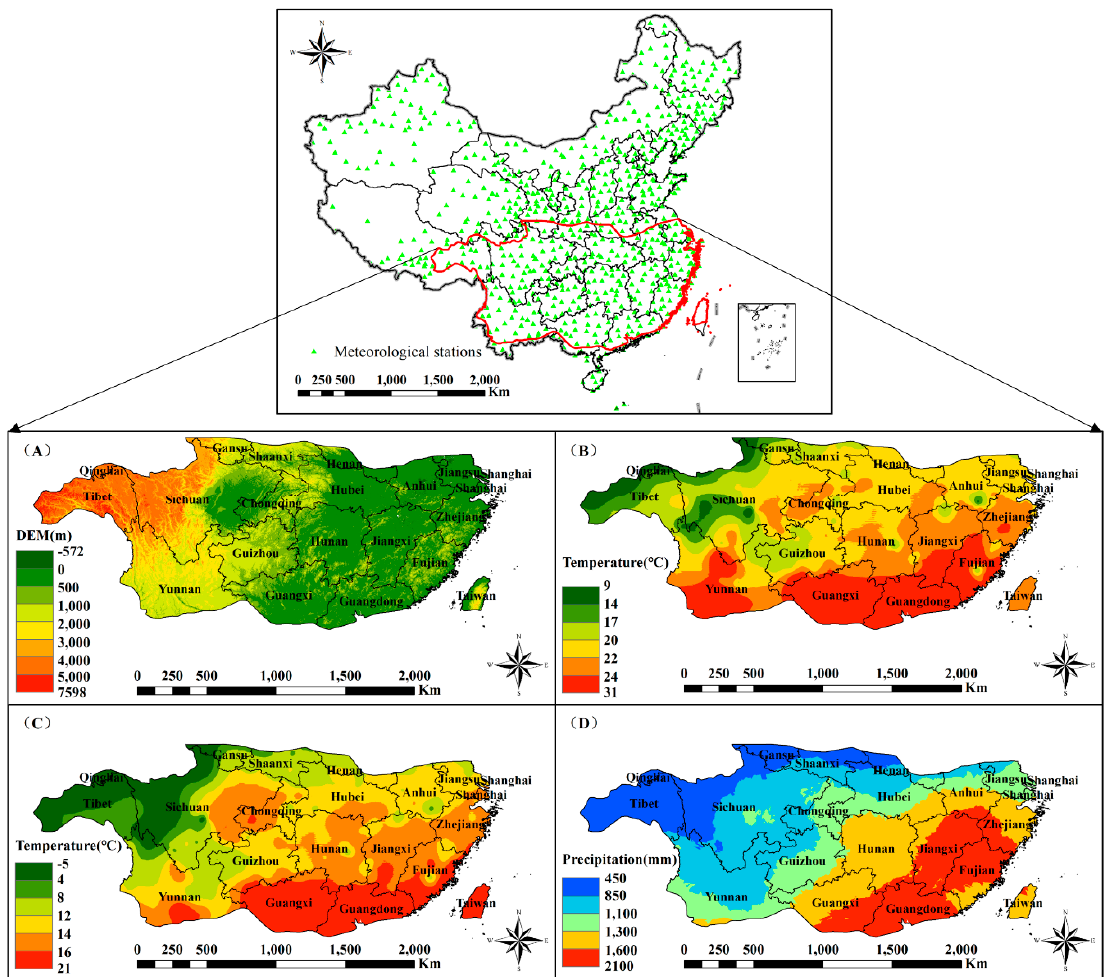
Figure 1. Location of study area: ( A ) digital elevation model (DEM), the spatial distribution of ( B ) Tmax, ( C ) Tmin, and ( D ) Pre in the subtropical region from 2001 to 2018.